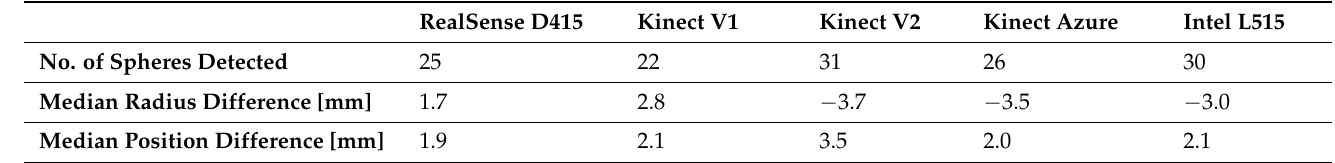
Figure 15. Plots showing the output of the RANSAC algorithm on the grape depth scans which were captured indoors. This is overlaid over a greyscale photo of the grape bunch for reference. Table 4. Information on the RANSAC algorithm fitting of spheres to individual grapes in the scans. This shows the number of spheres detected and the median difference in the radius and 2D positions of the spheres for the RGB-D cameras relative to the same spheres in the photogrammetry scans. RealSense D415 Kinect